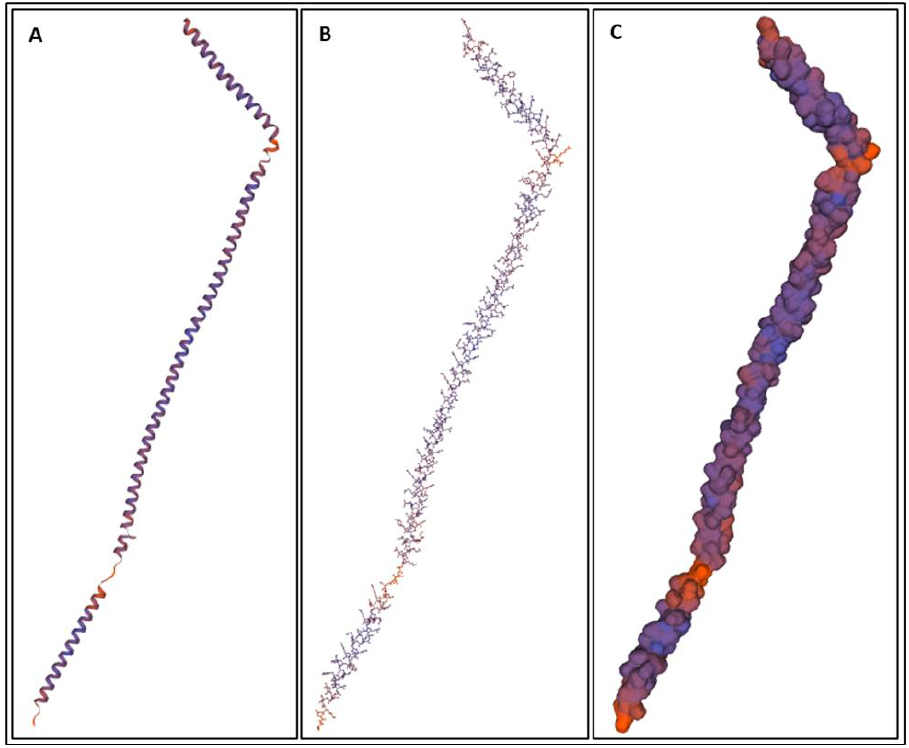
Figure 5. ( A ) A cartoon model, ( B ) a ball-and-stick model, and ( C ) a surface model of NF-L [30].